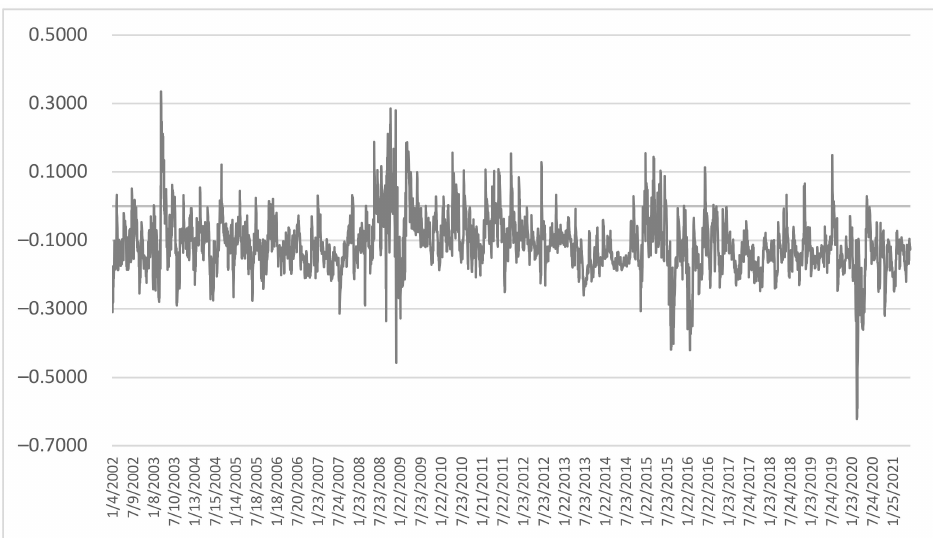
Figure 3. Estimation of the dynamic conditional correlation from model DCC(1,1) GARCH with the multivariate Student’s-t errors, between WTIF and NBXMBIS.